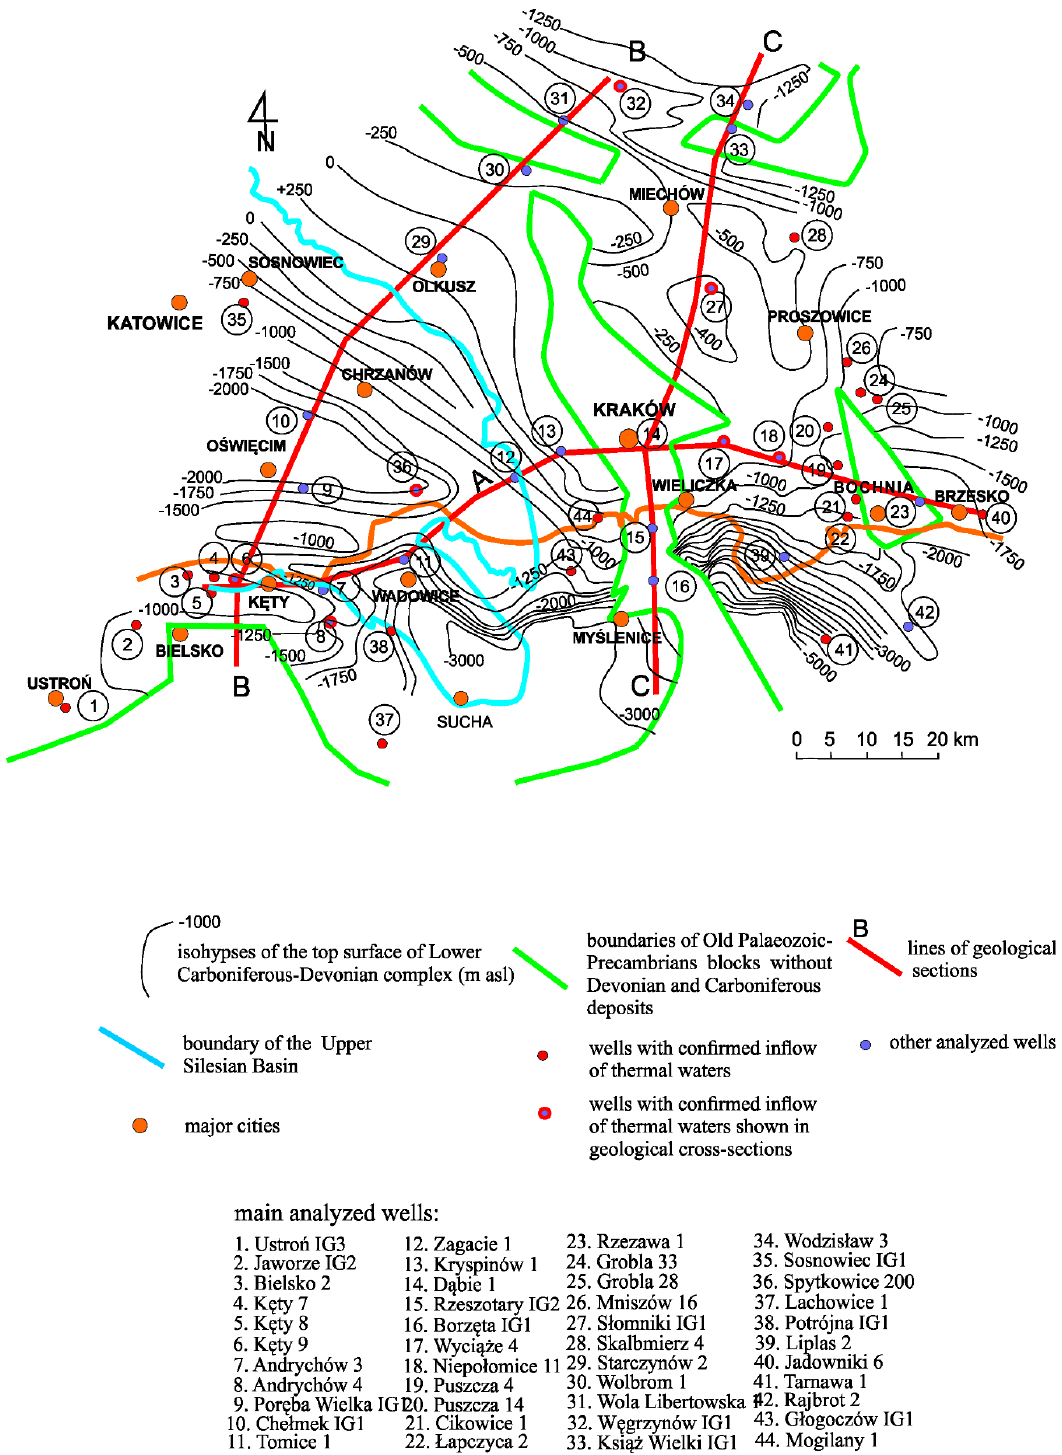
Figure 6. Structural map of the top surface of the Lower Carboniferous–Devonian complex in the analyzed part of the Silesia–Krakow region, well numbers as in Table 1 (based on PGNiG SA and PIG borehole data, CBDG PIG-PIB portal and according to [5–7,9,10]).